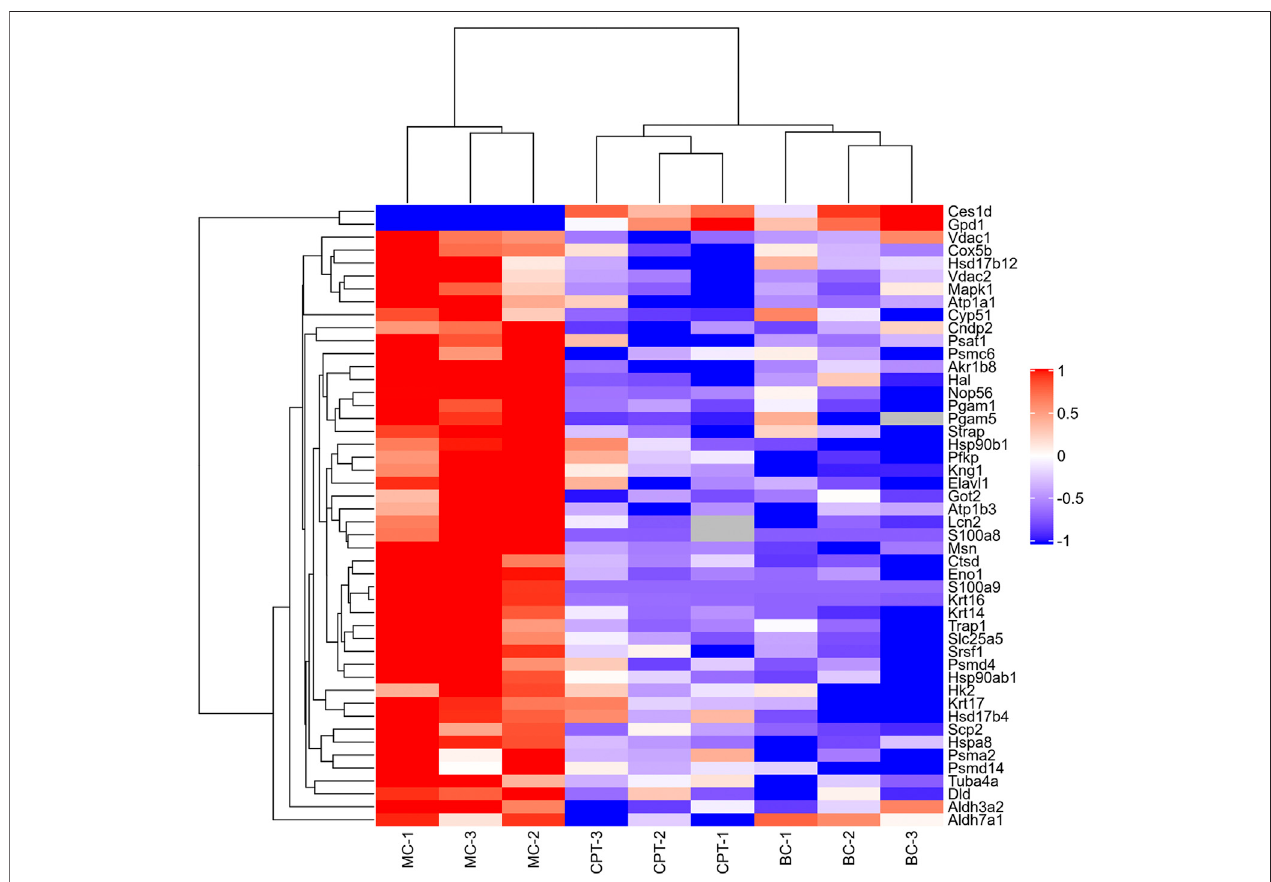
FIGURE 3 | Hierarchical clustering heat map of DEPs of the skin. Changed proteins (right side) and the samples in different groups (bottom). The color from red to blue shows the relative intensity of the DEPs.